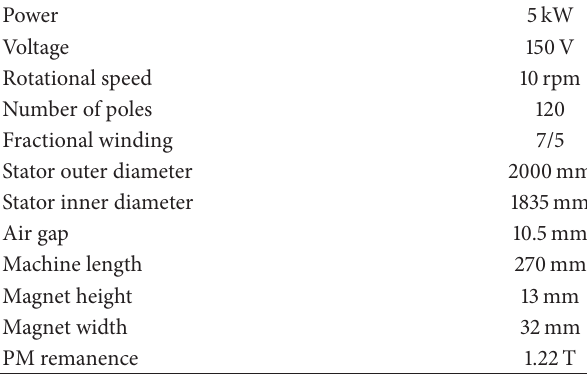
Table 1: Reference machine main design parameters.